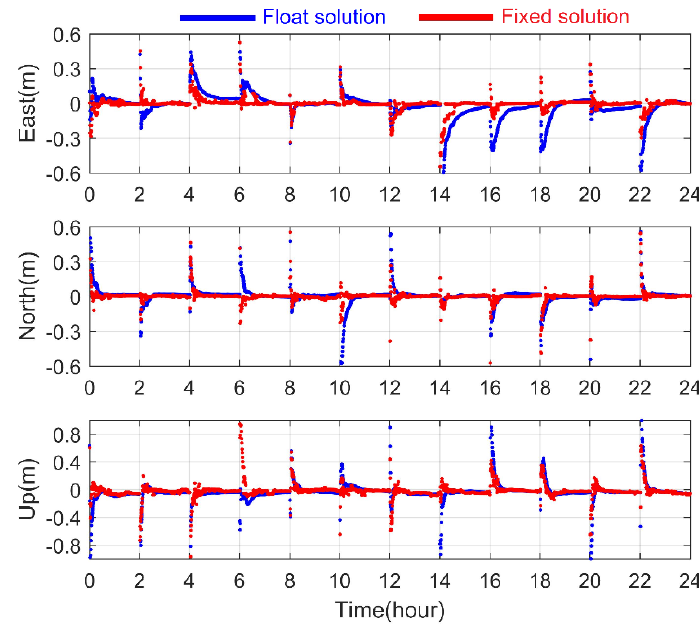
Figure 2. Coordinate residual series of float and fixed solutions at BOR1 station. Table 1. Coordinate residuals and convergence time of uncombined PPP.